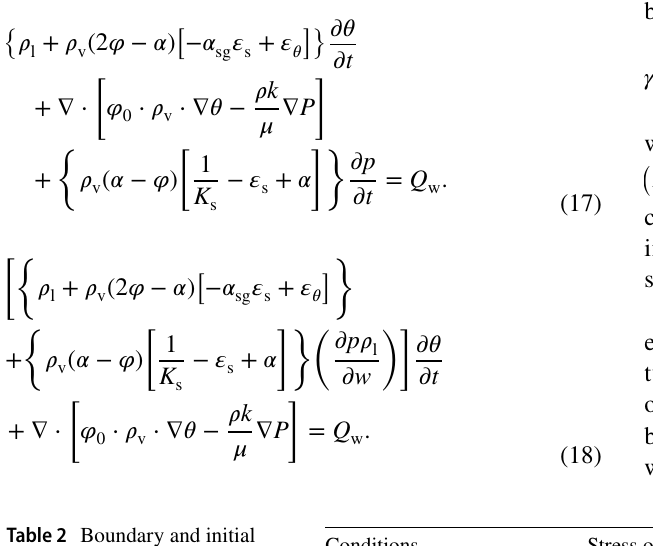
Table 2 Boundary and initial conditions